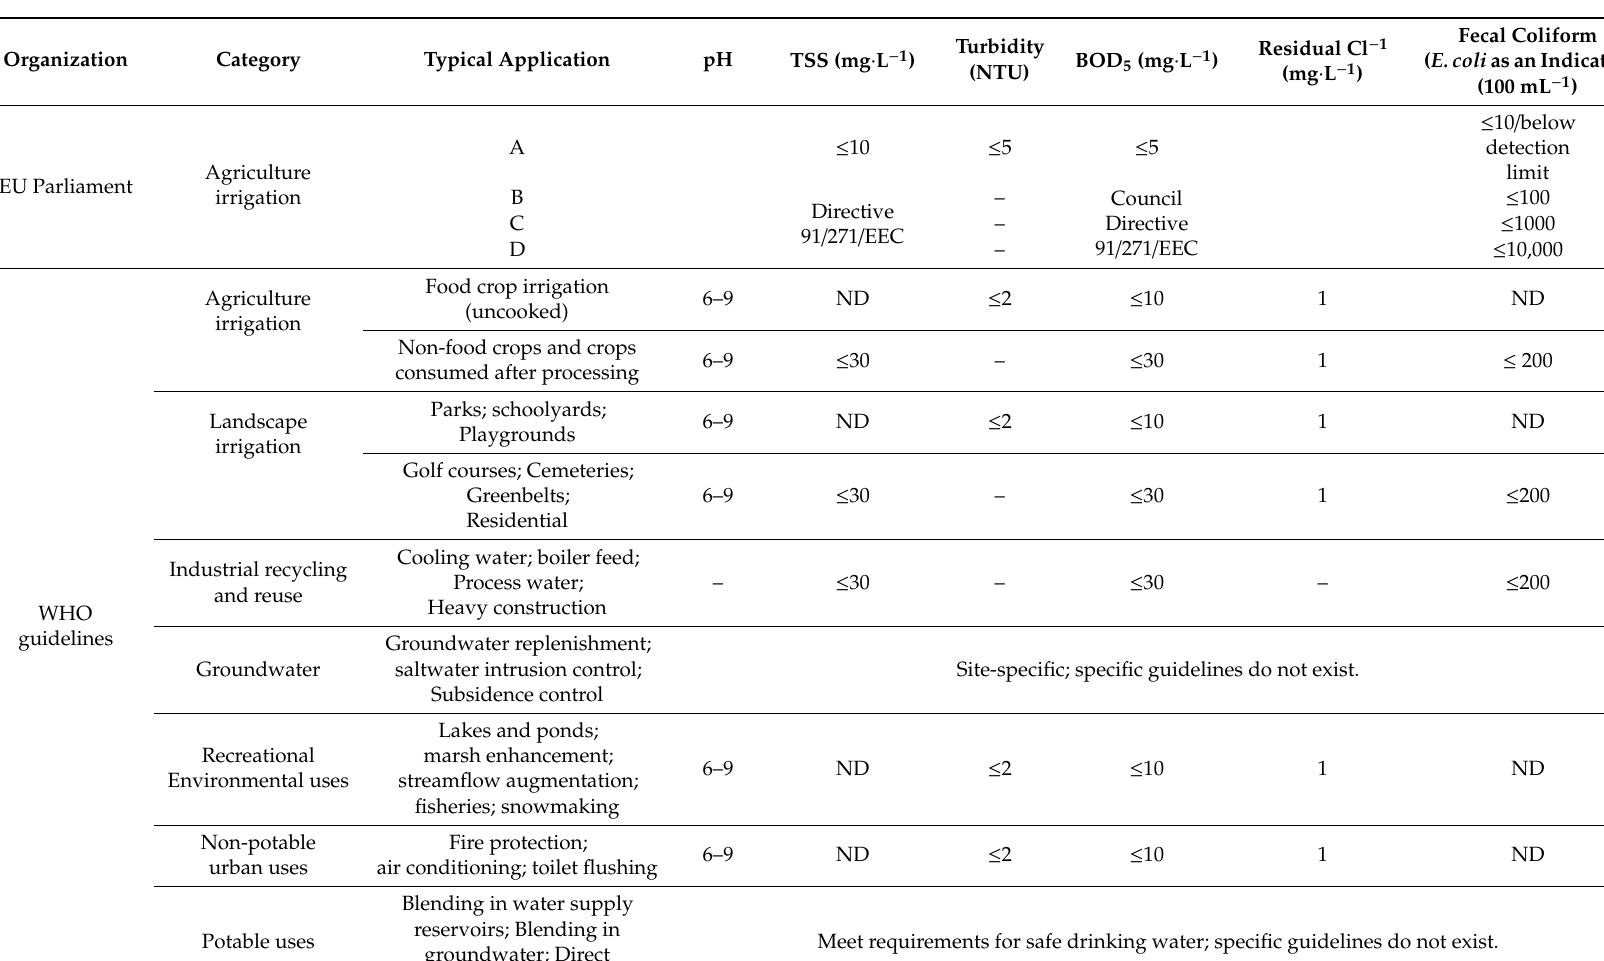
Table 4. Water reuse categories and typical application (WHO guidelines and EU Parliament regulation